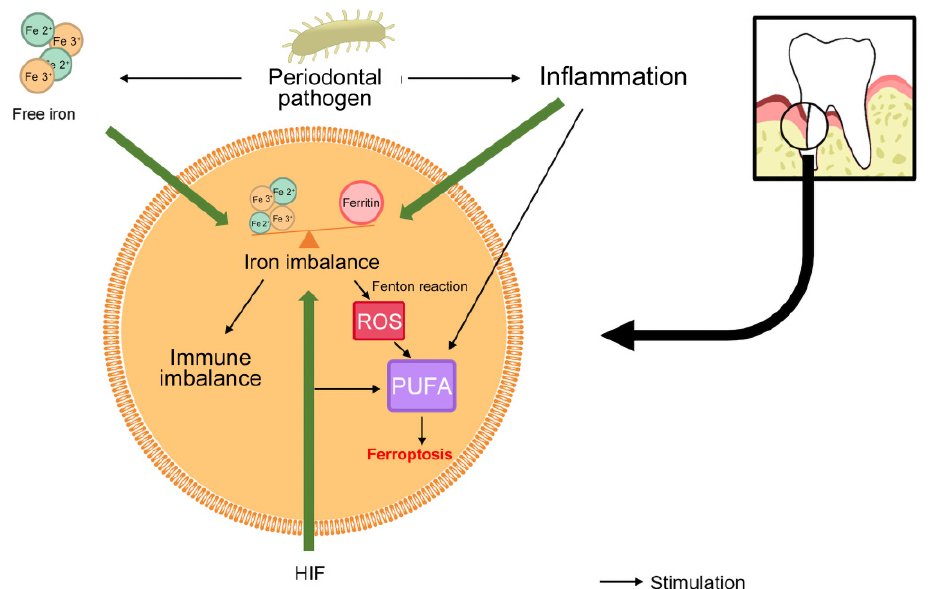
Figure 2. Ferroptosis programs in the periodontal microenvironment. In the periodontitis environment, inflammation, HIF, and iron concentration influence intracellular iron homeostasis. Intracellular iron homeostasis is responsible for immune homeostasis. In an inflammatory state, periodontal pathogenic micro-organisms up-regulate iron ion concentration through metabolism. At the same time, inflammation and HIF promote the deposition of PUFA in cells. When intracellular iron homeostasis is unbalanced, the Fenton reaction will occur and reactive oxygen species will be generated to peroxidation of intracellular PUFA and generate lipid peroxides to accelerate the process of cell ferroptosis. Abbreviations—ROS, reactive oxygen species; PUFA, polyunsaturated fatty acids; HIF, hypoxia-inducible factor.